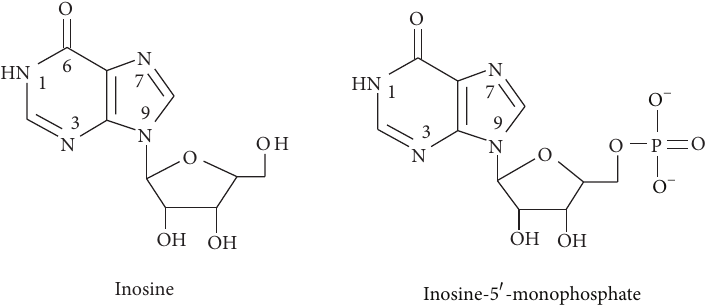
Scheme 1: Chemical structure of investigated